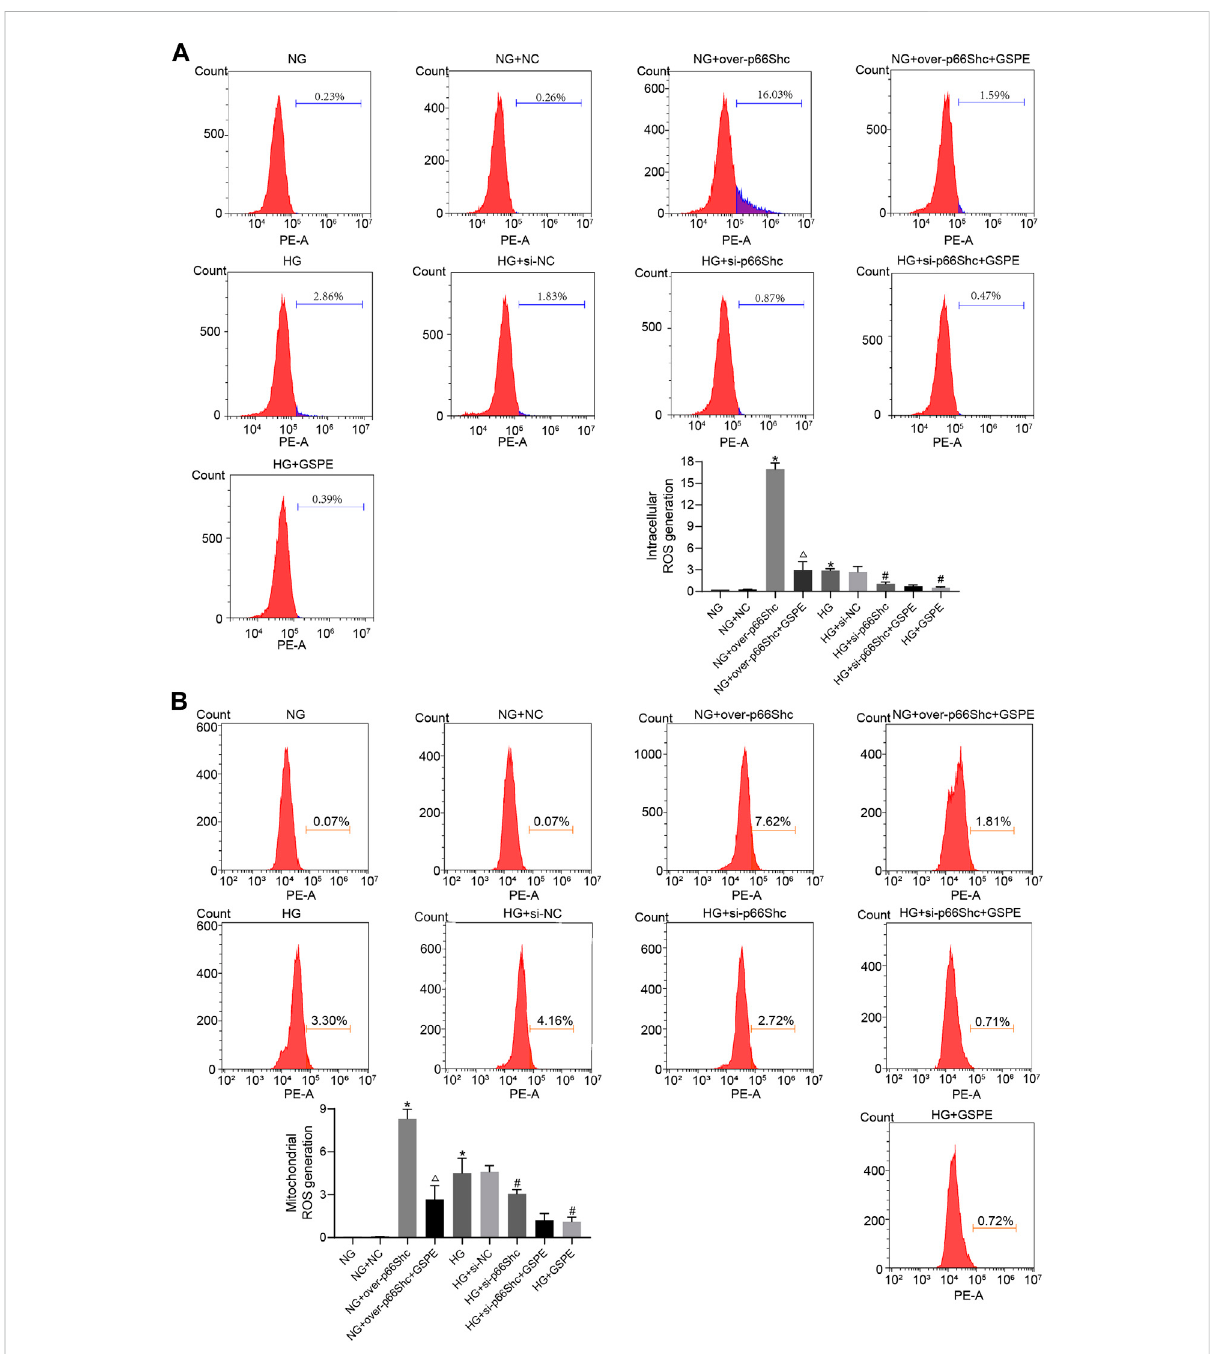
FIGURE 9 (A) Assessment of intracellular ROS generation in various treated groups by DCFH-DA staining. Mean ± SD. n = 3. p p < 0.05 vs. NG group; # p < 0.05 vs. HG group; △ p < 0.05 vs. NG + over-p66Shc group. (B) Assessment of mitochondrial ROS generation in various treated groups by